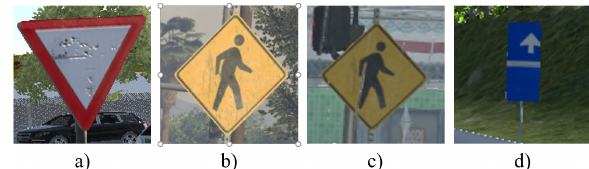
Figure 6. Examples of synthetic images of traffic signs from different datasets: With modifications applied: a) painting chipping off from the sign, b) dirt and reflections on the sign, c) during rain. Without modifications: d) meaningless sign.